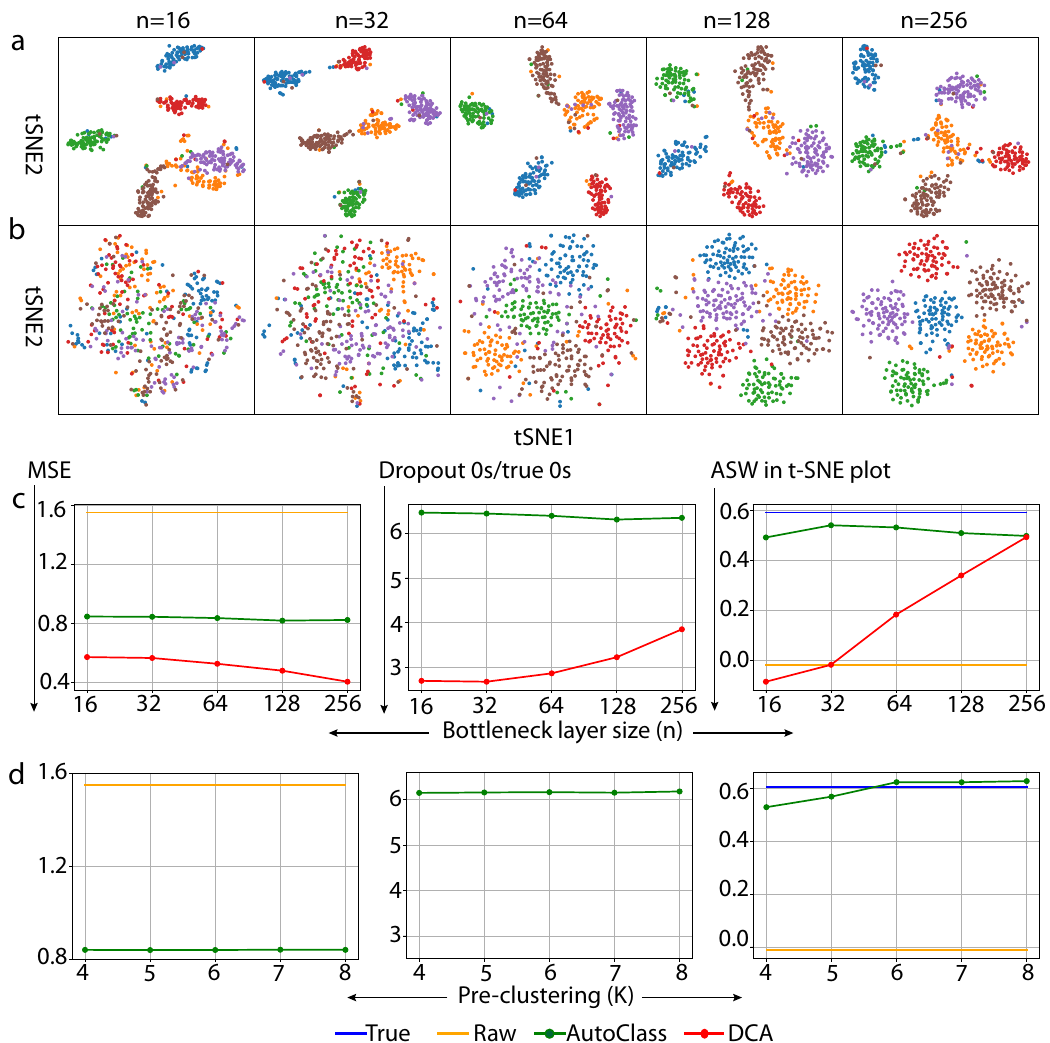
Fig. 6 Impact of bottleneck layer size and the number of clusters in the pre-clustering in Dataset 1. t-SNE plots of data imputed by AutoClass ( a ) and DCA ( b ) with different bottleneck sizes ( n ). Imputation results by AutoClass with bottleneck layer size ( c ) and the number of clusters in the pre-clustering ( d ).